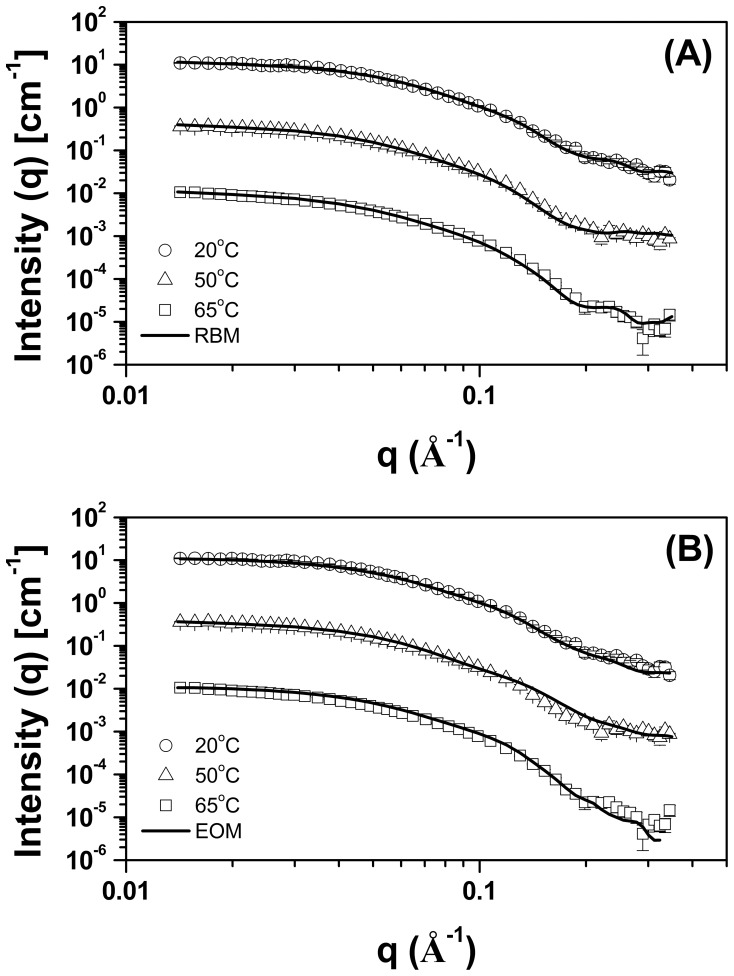
RBM and EOM fits.(A) Experimental SAXS curves of the TpMan at 20°C (open black circles with errors bars), 50°C (open black triangles with errors bars) and 65°C (open black squares with errors bars) superimposed on the computed scattering curves based on the rigid-body models (RBMs, solid black lines). (B) Fits (solid black lines) of the best profiles determined by EOM modeling to the SAXS data collected at pH 6.0 and 20°C (open black circles with errors bars), 50°C (open black triangles with errors bars) and 65°C (open black squares with errors bars).